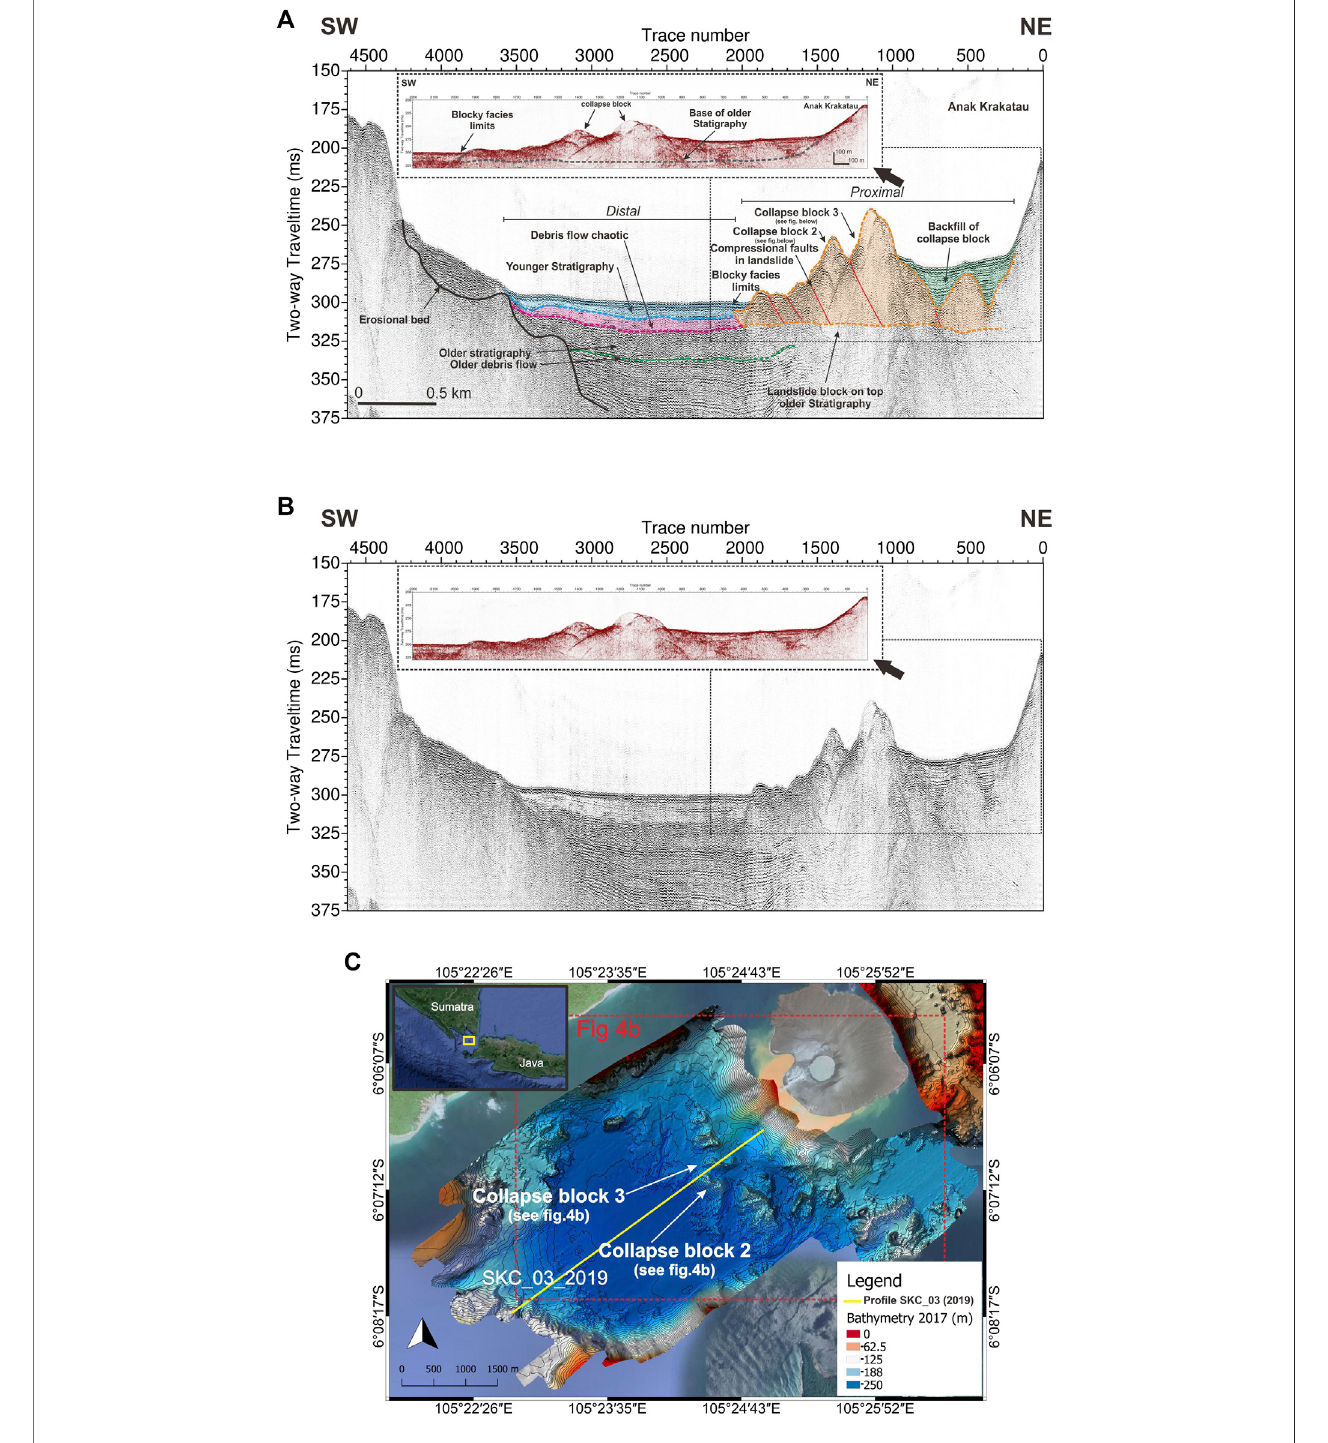
FIGURE 6 | Seismic Pro fi le SKC-03 (2019 Data) with 5:1 exaggeration (The light-brown striped line is consider as basal collapse block). (A) Interpreted of the Seismic Pro fi le SKC-03. (B) Un interpreted of Seismic Pro fi le SKC-03. (C) The Seismic Pro fi le SKC-03 location.